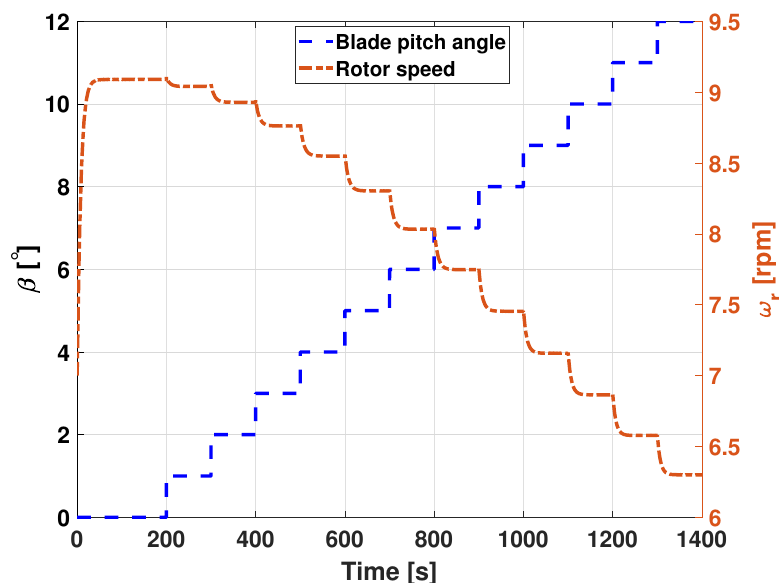
Figure 23. Rotor speed dynamics for step changes in β ( V = 8 m/s).